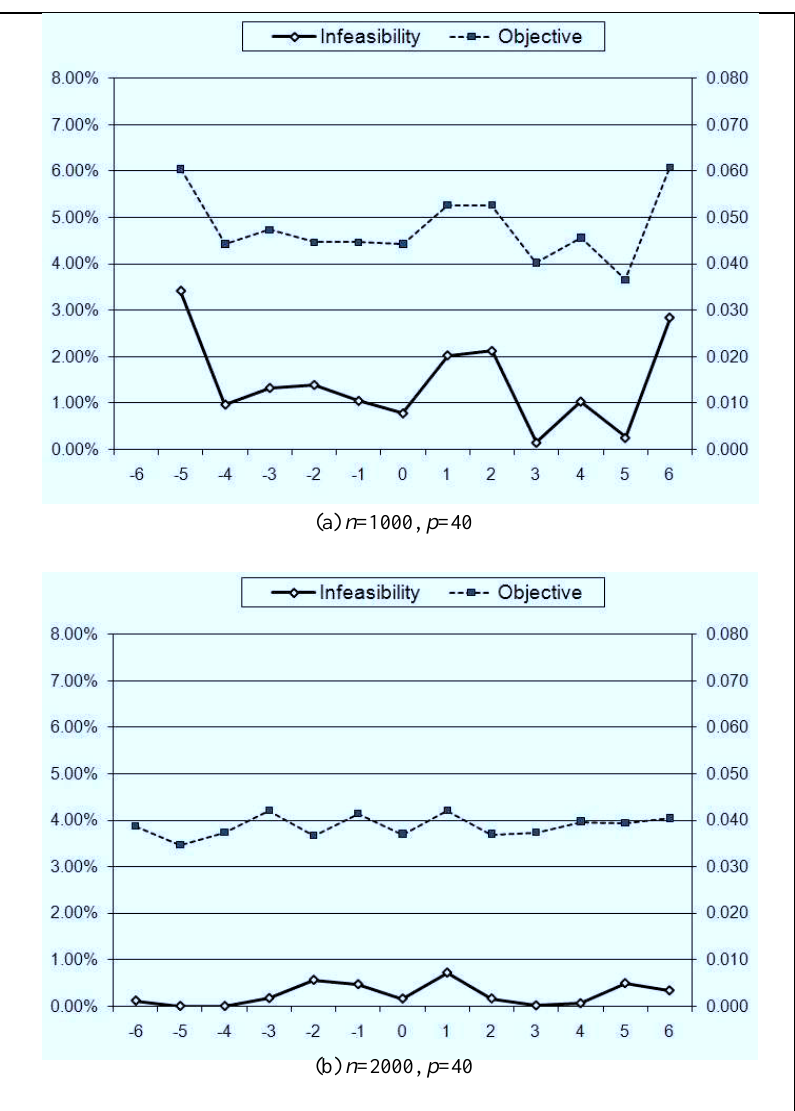
Fig. 9. Steepest descent average results for objective func- tion and infeasibility values for p =40